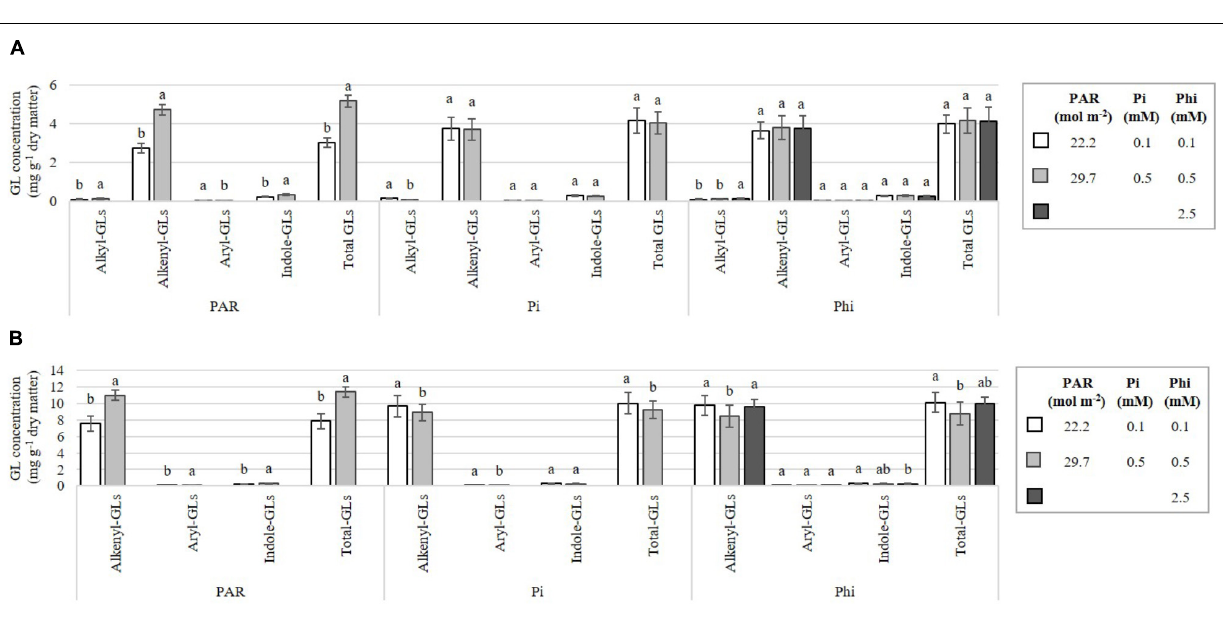
FIGURE 8 | Influence of mean daily photosynthetically active radiation (PAR), phosphate (Pi), and phosphite (Phi) on the alkyl-, alkenyl-, aryl-, indole-, and total glucosinolate (GL) concentrations. Bars ± SD with different letters indicate significant differences at P ≤ 0.05 (Tukey’s test). (A) B. campestris cv. Mibuna Early. (B) B. juncea cv. Red Giant.